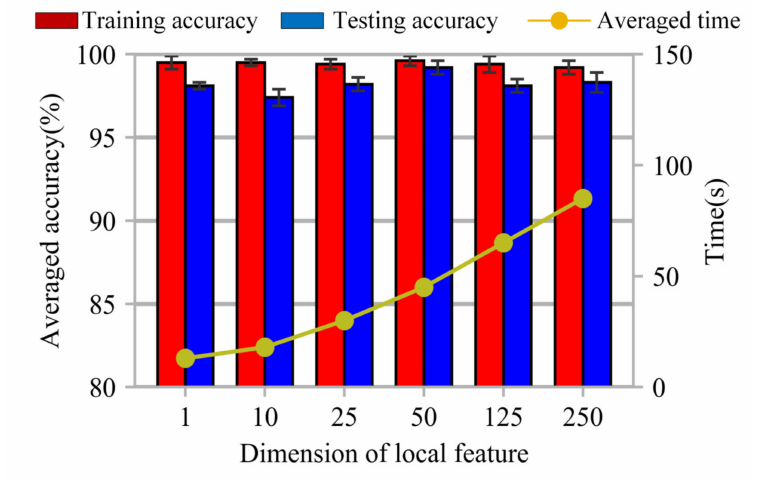
Figure 3. Diagnostic accuracy of the proposed method according to different values of the hyperpa- rameter V .